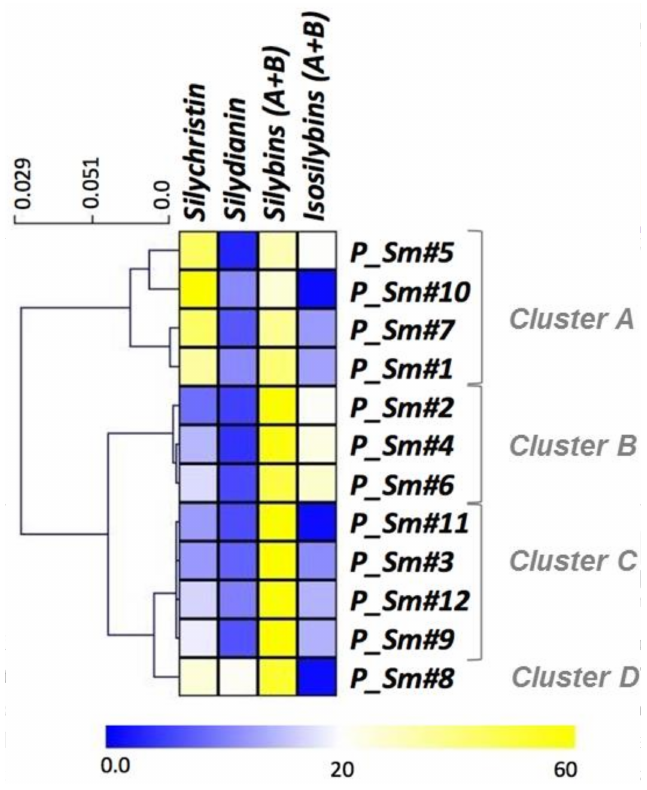
Figure 4. Hierarchical clustering analysis of twelve inflorescences of Silybum marianum related to their phytochemical